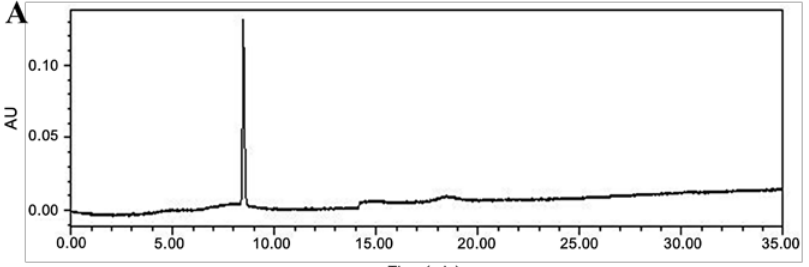
Figure 1. High performance liquid chromatography (HPLC) chromatograms of Z-ligustilide ( A ) and A. sinensis extract ( B ). Detection was performed using a photodiode array detector. X -axis is retention time (min); Y -axis is absorbance unit